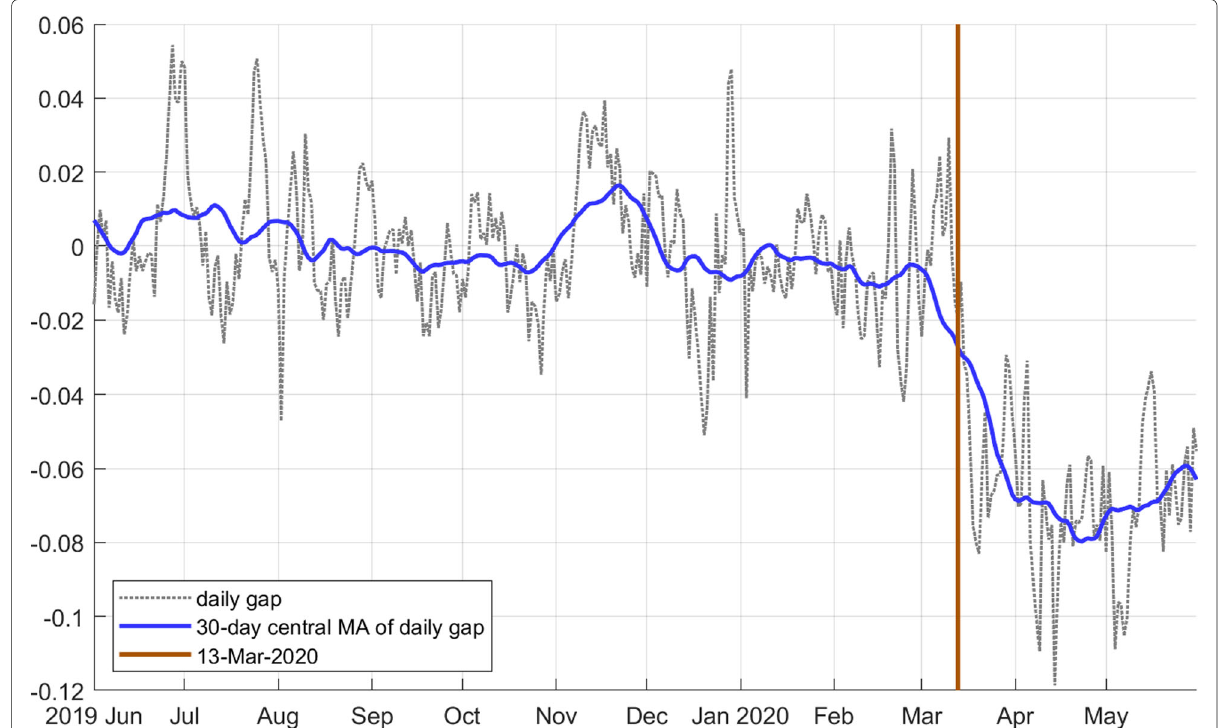
Fig. 4 Daily electricity gap g (black dotted line), 30-day central moving average (blue) last 12 months